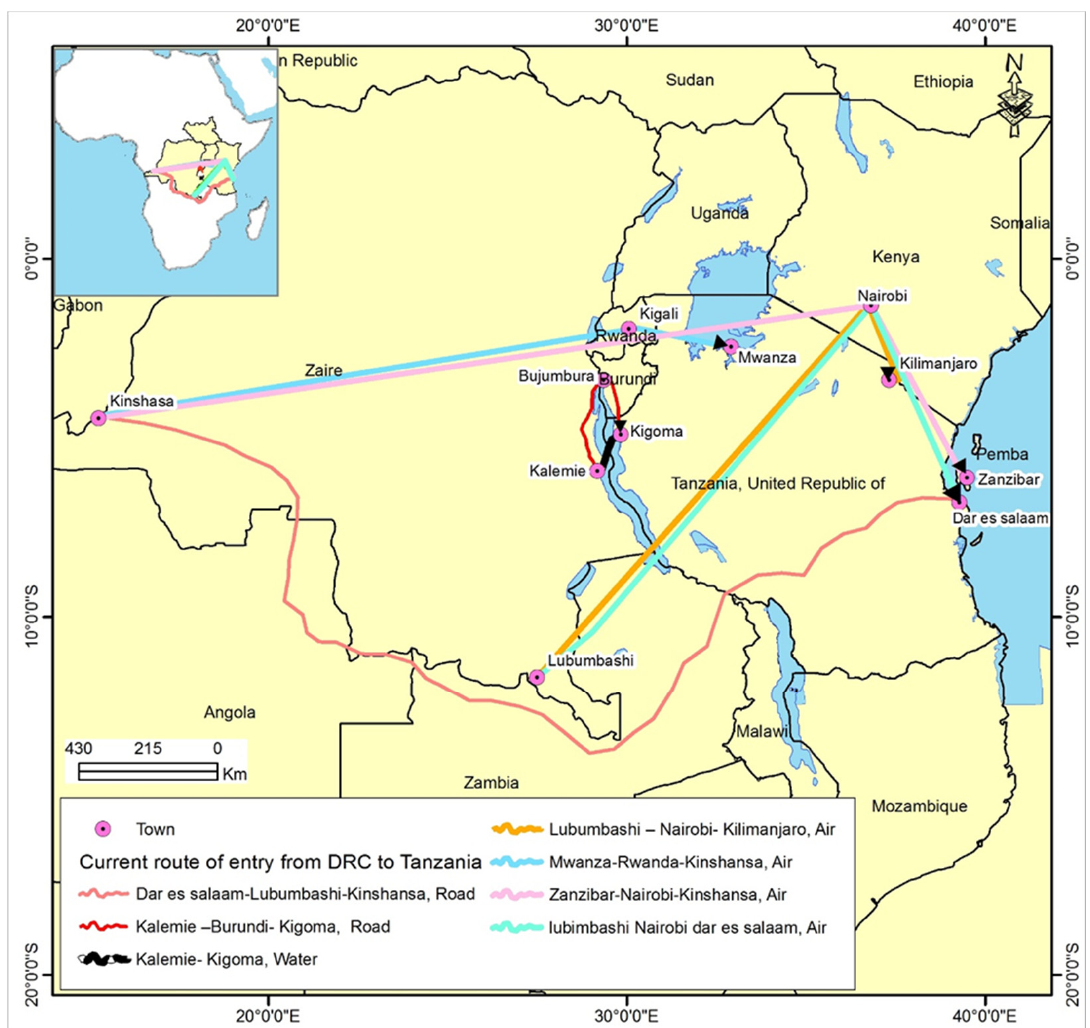
Figure 2. Current routes of entry from DRC to Tanzania.